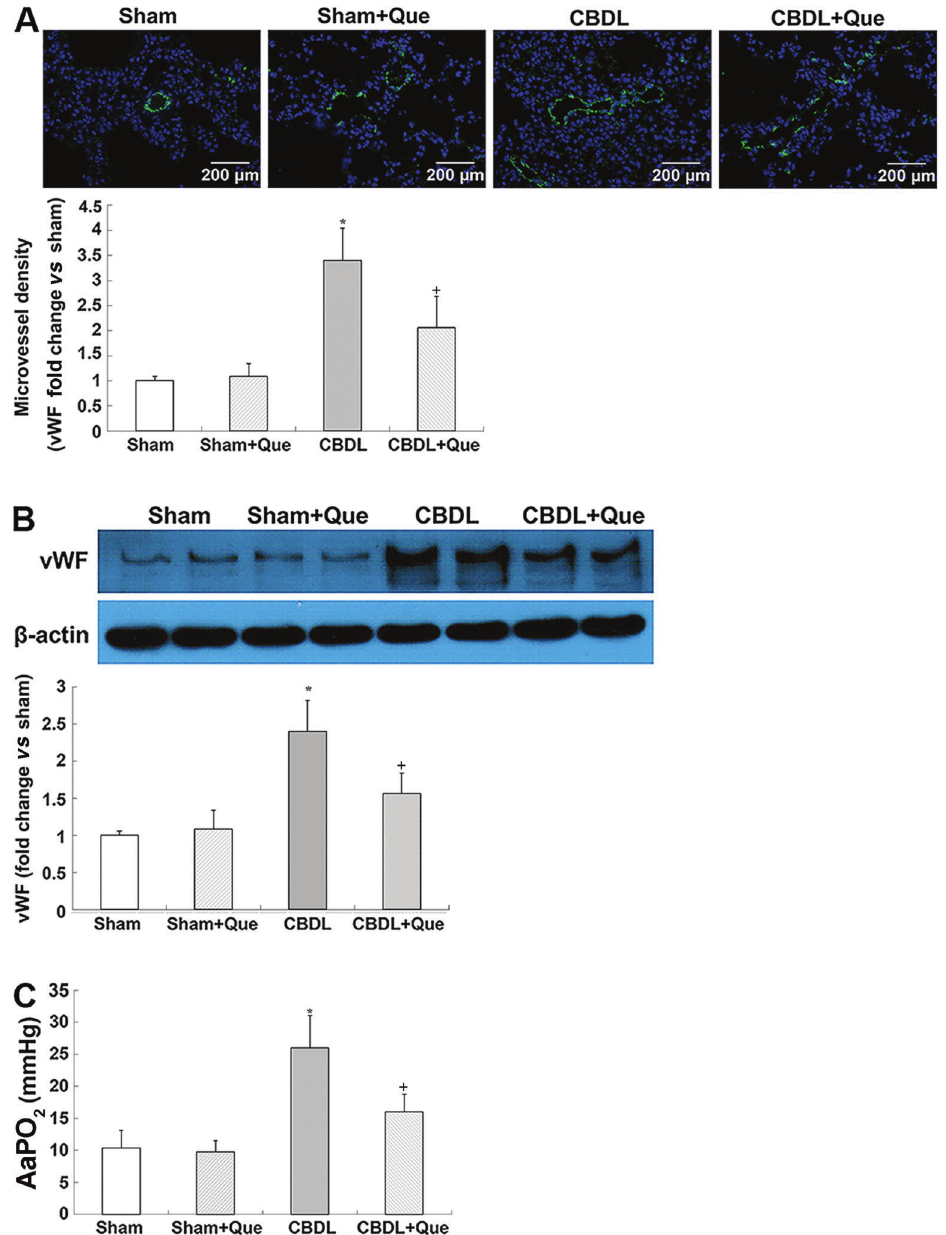
Figure 1. Effects of quercetin on pulmonary von Willebrand Factor (vWF) immunostaining levels, alveolar-arterial oxygen gradients, and portal hypertension and hepatic fi brosis in common bile duct ligation (CBDL) rats, sham-operated rats (Sham), Sham + quercetin (Que) rats, and CBDL + quercetin (CBDL + Que) rats. A , immunostaining of vWF (green) with DAPI nuclear stain (blue) and lung microvessel density. ( B ), pulmonary expression of vWF protein levels and lung microvessel density. C , summary of alveolar arterial oxygen pressure gradient (AaPO 2 ) in all groups. Sham, n=8; CBDL, n=6; Que, n=8; CBDL + Que, n=8. Data are reported as mean ± SD. *P o 0.05 compared with sham rats. + P o 0.05 compared with CBDL rats